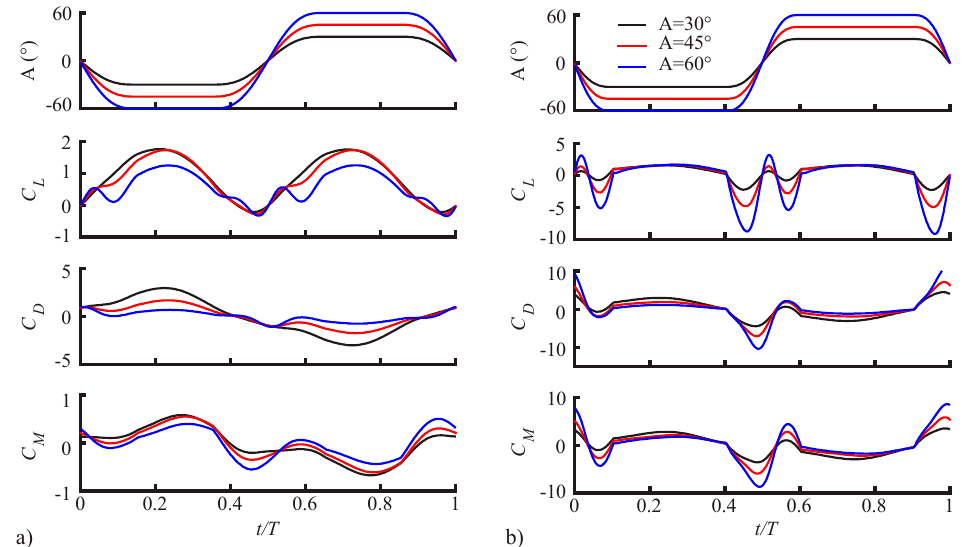
Figure 5. Plots of the predicted lift, drag, and moment coefficient for cases with changing pitching amplitude, A = 30° (black), A = 45° (red) and A = 60° (blue). ( a ) Mild motions with Δ τ r = 0.3 and x pa = 0.5; ( b ) Extreme motions with Δ τ r = 0.2 and x pa = 1.0.